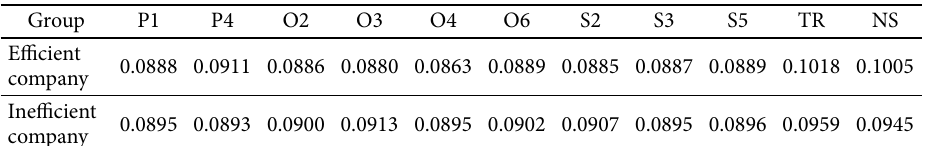
Table 8. Results of the entropy weight for the 11 representative indicators Group P1 P4 O2 O3 O4 O6